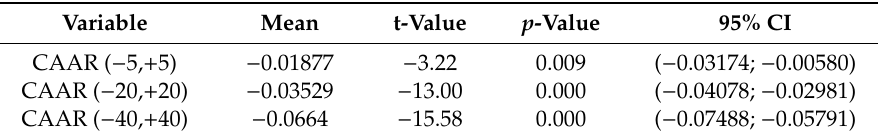
Figure 3. t -Test P-P plot of CAAR for E ( − 40,+40) . Figure 4. t -Test histogram of CAAR for E ( − 20,+20).